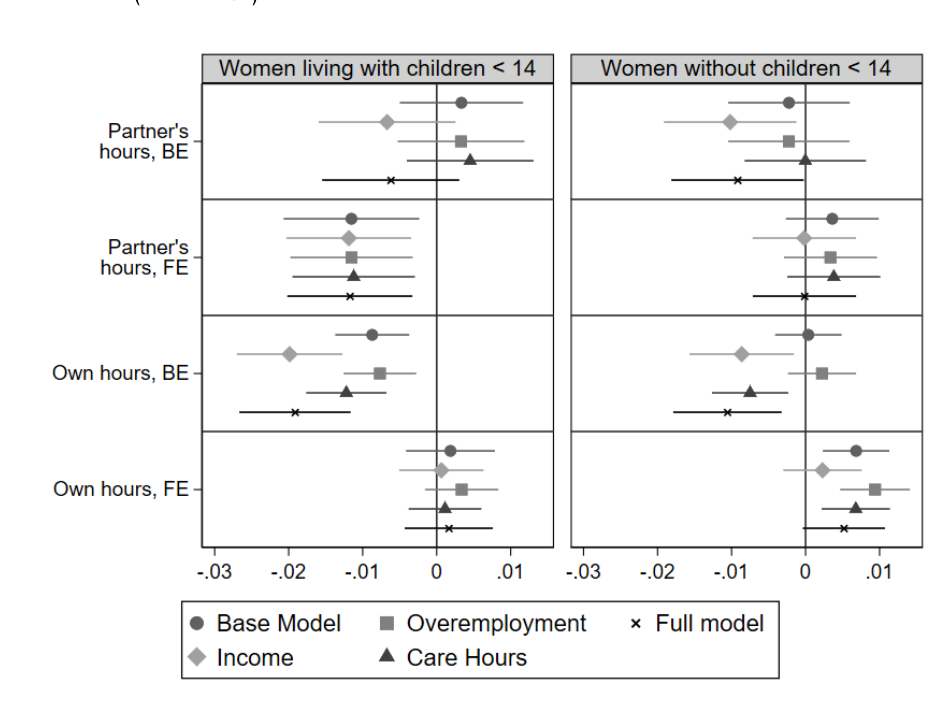
Figure 1 : Own and partner’s work hours coefficient from the hybrid models for women (Cls at